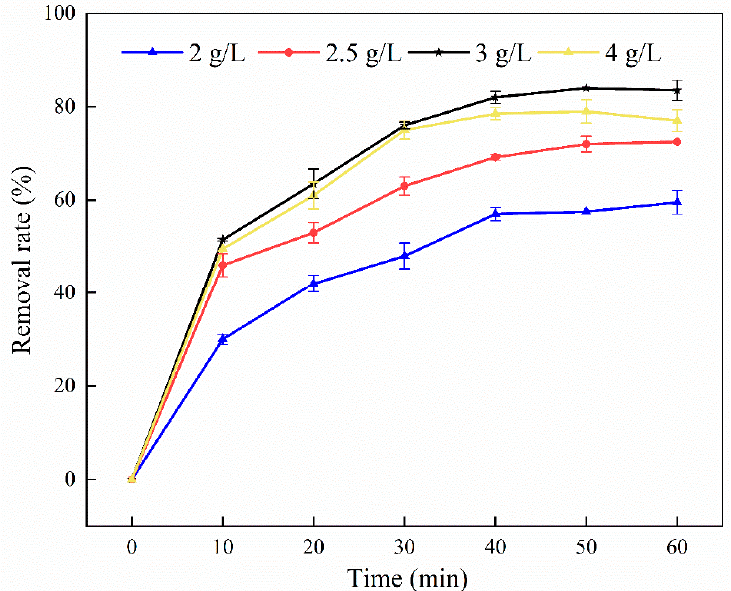
Figure 3. Effect of ZVI addition on degradation rate. Experimental conditions: [PS] = 21 mM; [ZVI] = 150 μ m; 25 °C, 160 rpm; no pH adjustment.